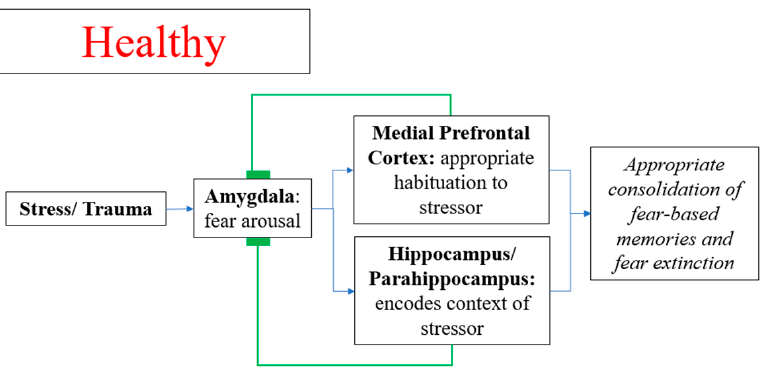
Figure 1. Consolidation of fear memory and extinction of fear in healthy individuals. Abnormal interactions between the amygdala and the hippocampus and mPFC are thought to underlie PTSD, resulting in over-consolidation of fear-based memories and/or weakened fear extinction, which is the decrease in the conditioned fear response [83,84]. The pathogenic mechanism is thought to be a process of fear conditioning marked by amygdala hyperarousal [84] and reduced mPFC activity, resulting in impaired extinction (Figure 2). Reduced hippocampal/parahippocampal activity is also implicated, resulting in over-generalization of fear to non-threatening stimuli and inability to differentiate safe and threatening contexts